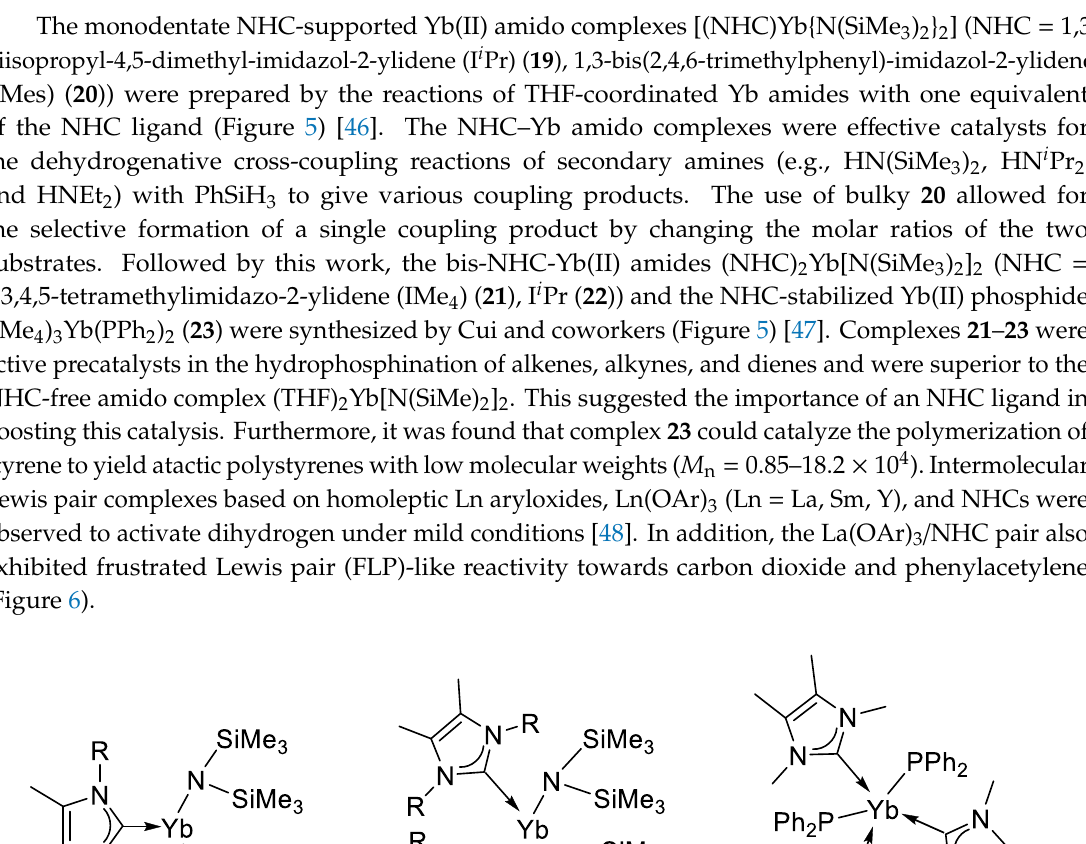
Figure 4. The trialkyl Sc complex bearing a bis(oxazoline)-derived NHC (IBiox) used for copolymerization of olefins.